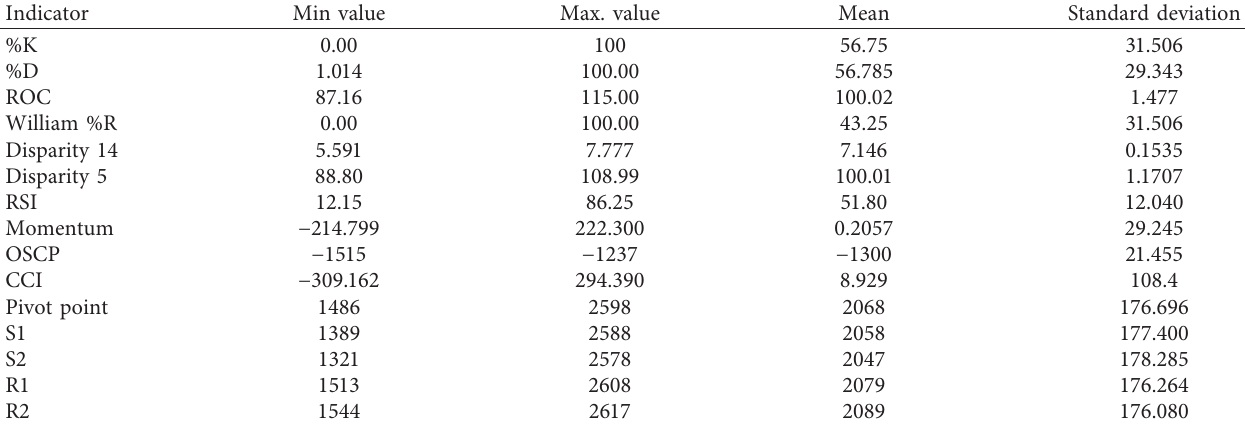
Table 3: Summary statistics of technical indicators for KOSPI index.